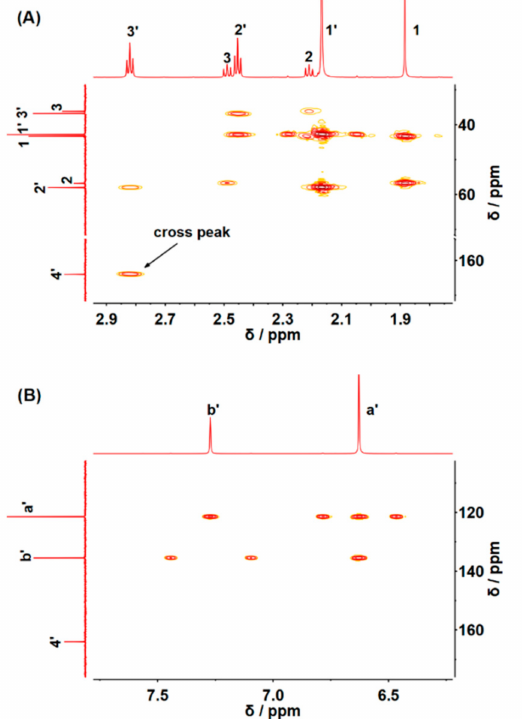
Figure 3. The 1 H- 13 C HMBC spectra of [DMEDAH] [Im] after CO 2 capture ( A , B ); D 2 O was used as the internal solvent to record the spectra.